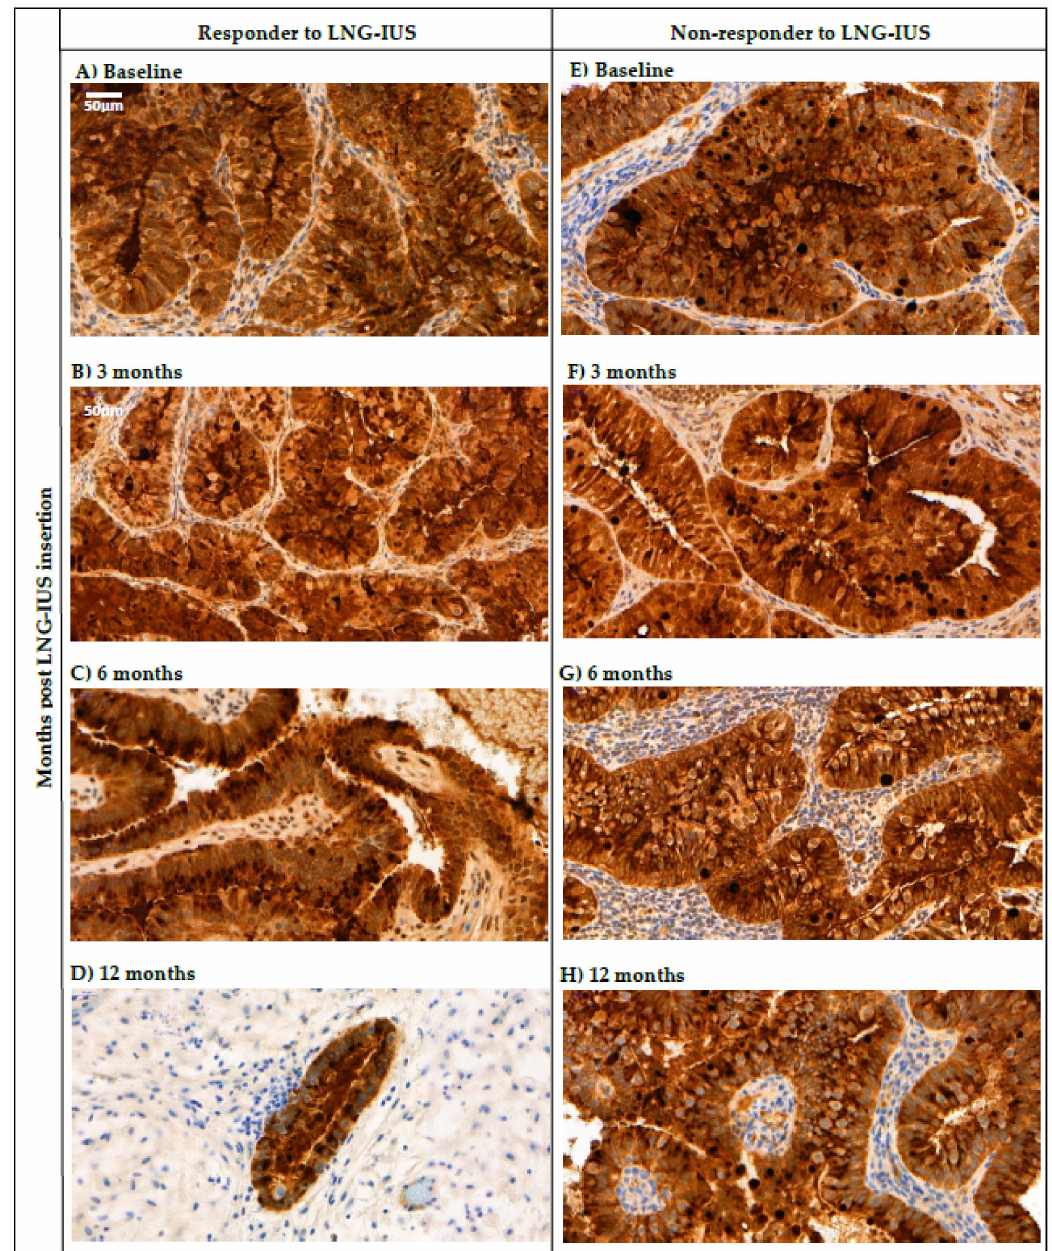
Figure 4. HE4 expression in endometrial biopsies taken from a responder ( A – D ) and non-responder ( E – H )totheLNG-IUSwithStageIaendometrialcanceratbaselineand3, 6, and12monthspost-LNG-IUS insertion. 40 × magnification using CaseViewer 3.2